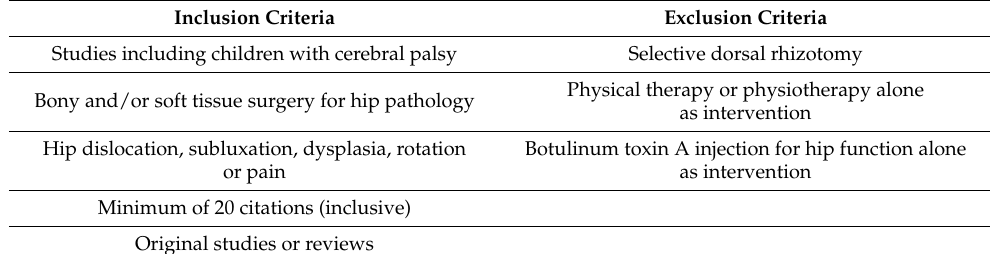
Table 1. Inclusion and exclusion